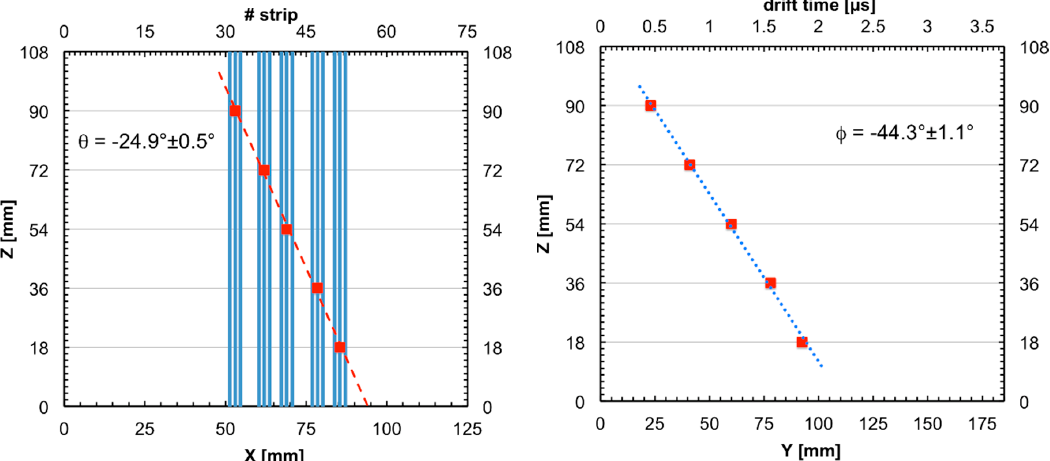
Figure 19. Example of a real track reconstruction. Left : XZ projection. Right : YZ projection.